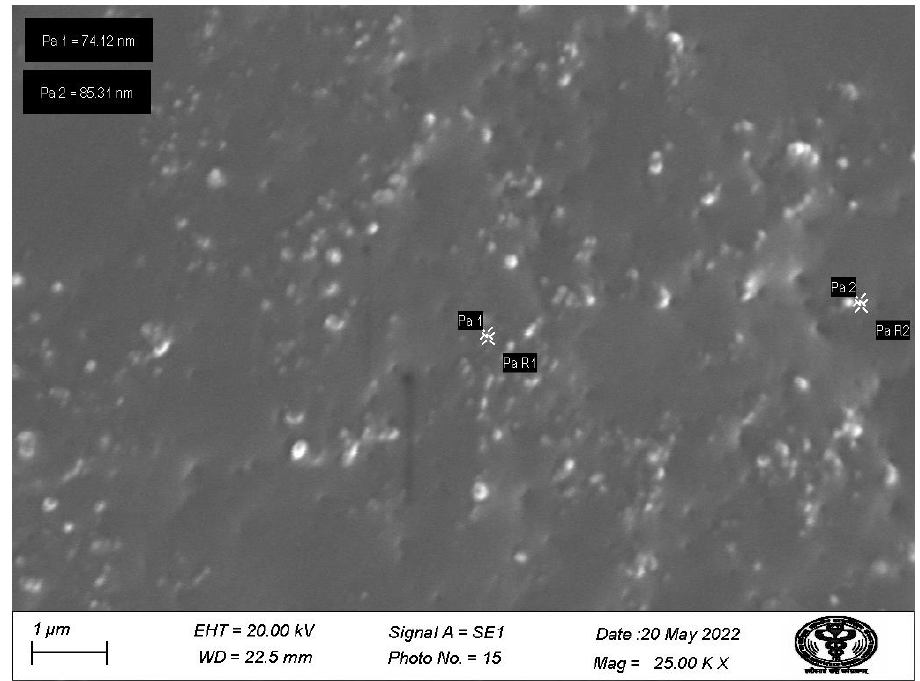
Figure 6. SEM micrograph obtained for QCT@NE.